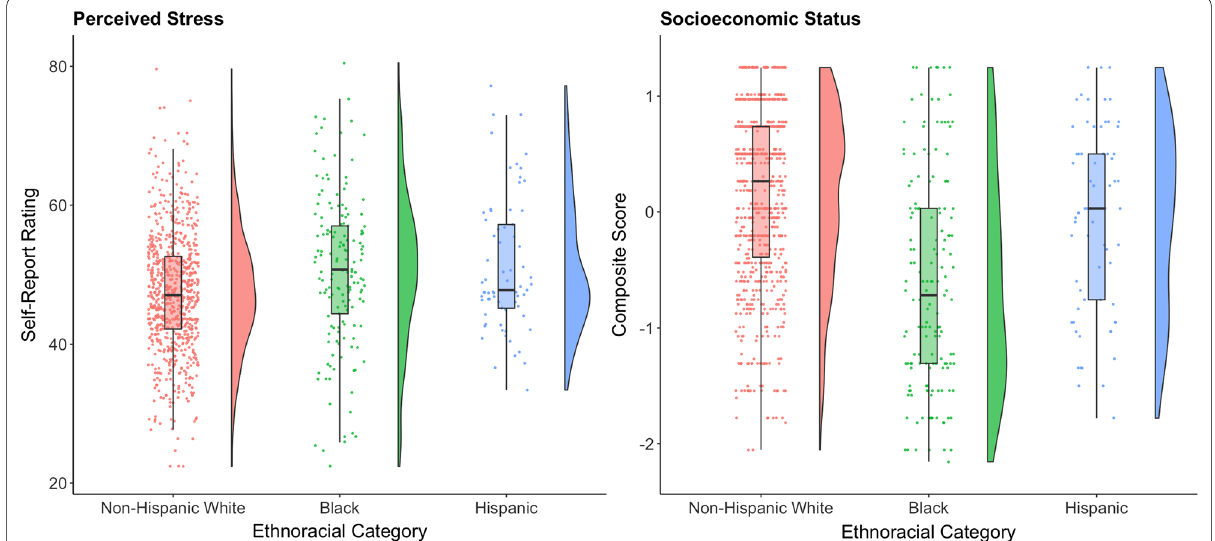
Fig. 1 Raincloud plots are presented illustrating ethnoracial category differences in perceived stress (left) and socioeconomic status (right) for Non‑Hispanic White Americans (red), Black American (green), and Hispanic Americans